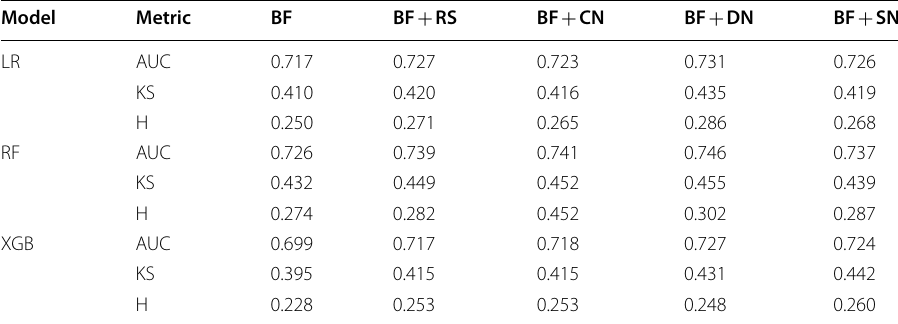
Each metric is measured in mean of 50 estimates obtained by repeating the outer ten-fold cross-validation procedure five times